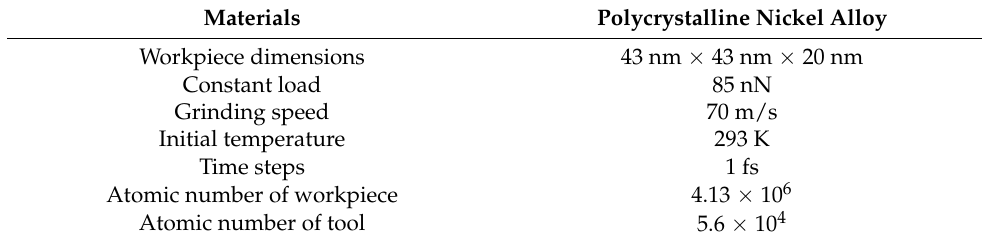
Figure 2. MD simulation model for nanoscale grinding of nickel-based polycrystalline superalloy. Table 1. Modeling parameters used in the